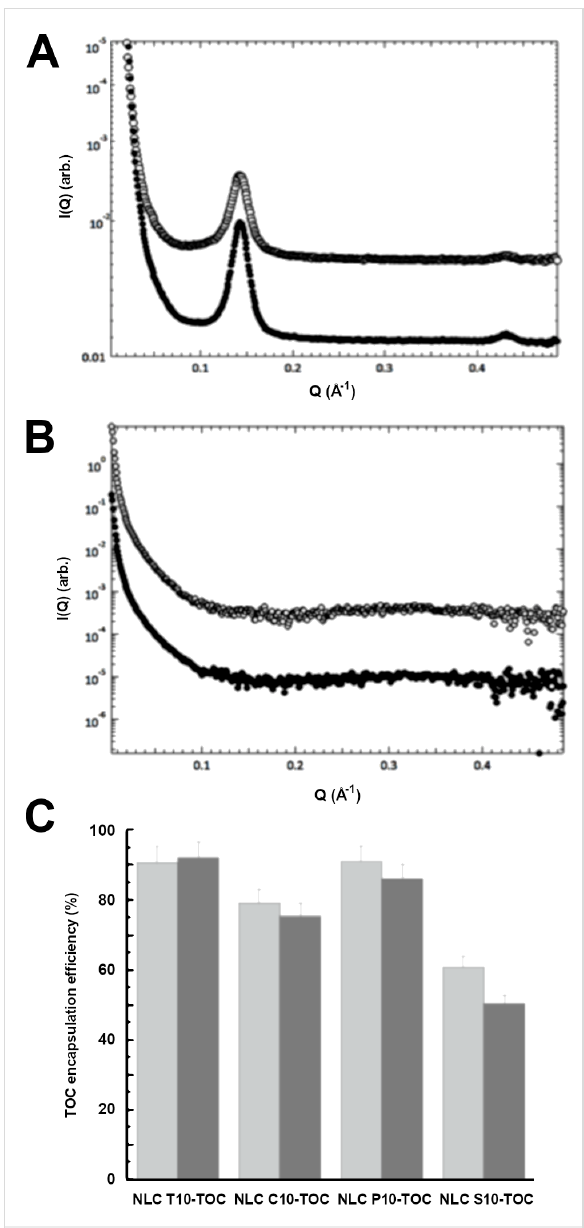
Figure 3: SAXS profiles observed for A: NLCT5-TOC (open symbol) and NLCT10-TOC (closed symbol), B: NLCS5-TOC (open symbol), and NLCS10-TOC (closed symbol). C: TOC encapsulation efficiency in the indicated NLC, evaluated at 1 (light grey) and 90 (grey) days after